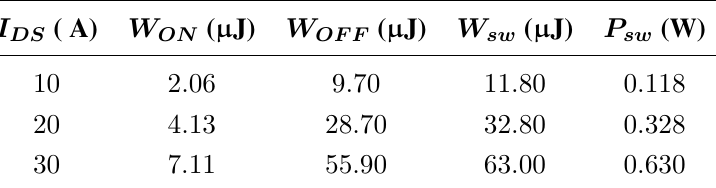
Table 4. Calculated switching losses by using Equation (10).